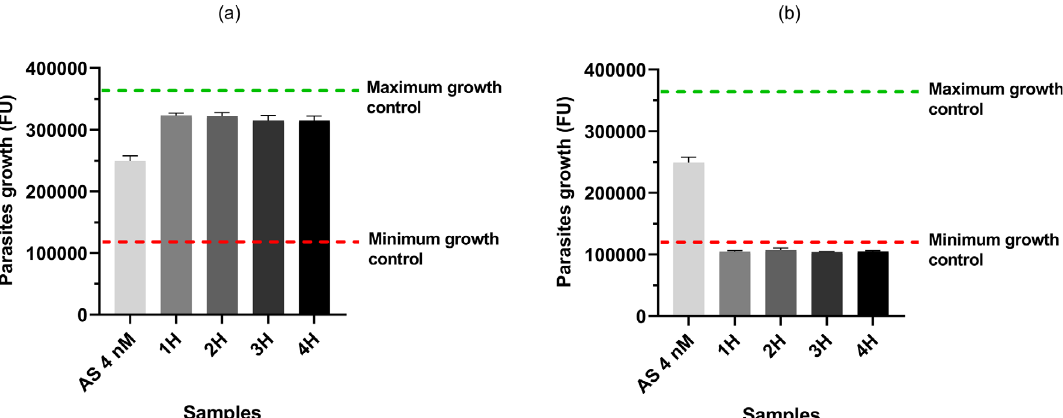
Figure 4. Antimalarial activity of the reference condition (AS 4 nM) and samples from (a) the permeation test using artesunate solution and (b) the permeation test using artesunate powder. Each sample was tested in triplicate. Data are presented as mean ± SD ( n = 3). AS = artesunate; FU = fl uorescence unit; Green dotted-line = threshold value for maximum parasite growth ( fl uorescence of parasites incubated without artesunate and KRB during the semi-quantitative test); Red dotted-line = threshold value for minimum parasite growth (parasite fl uorescence at the beginning of the